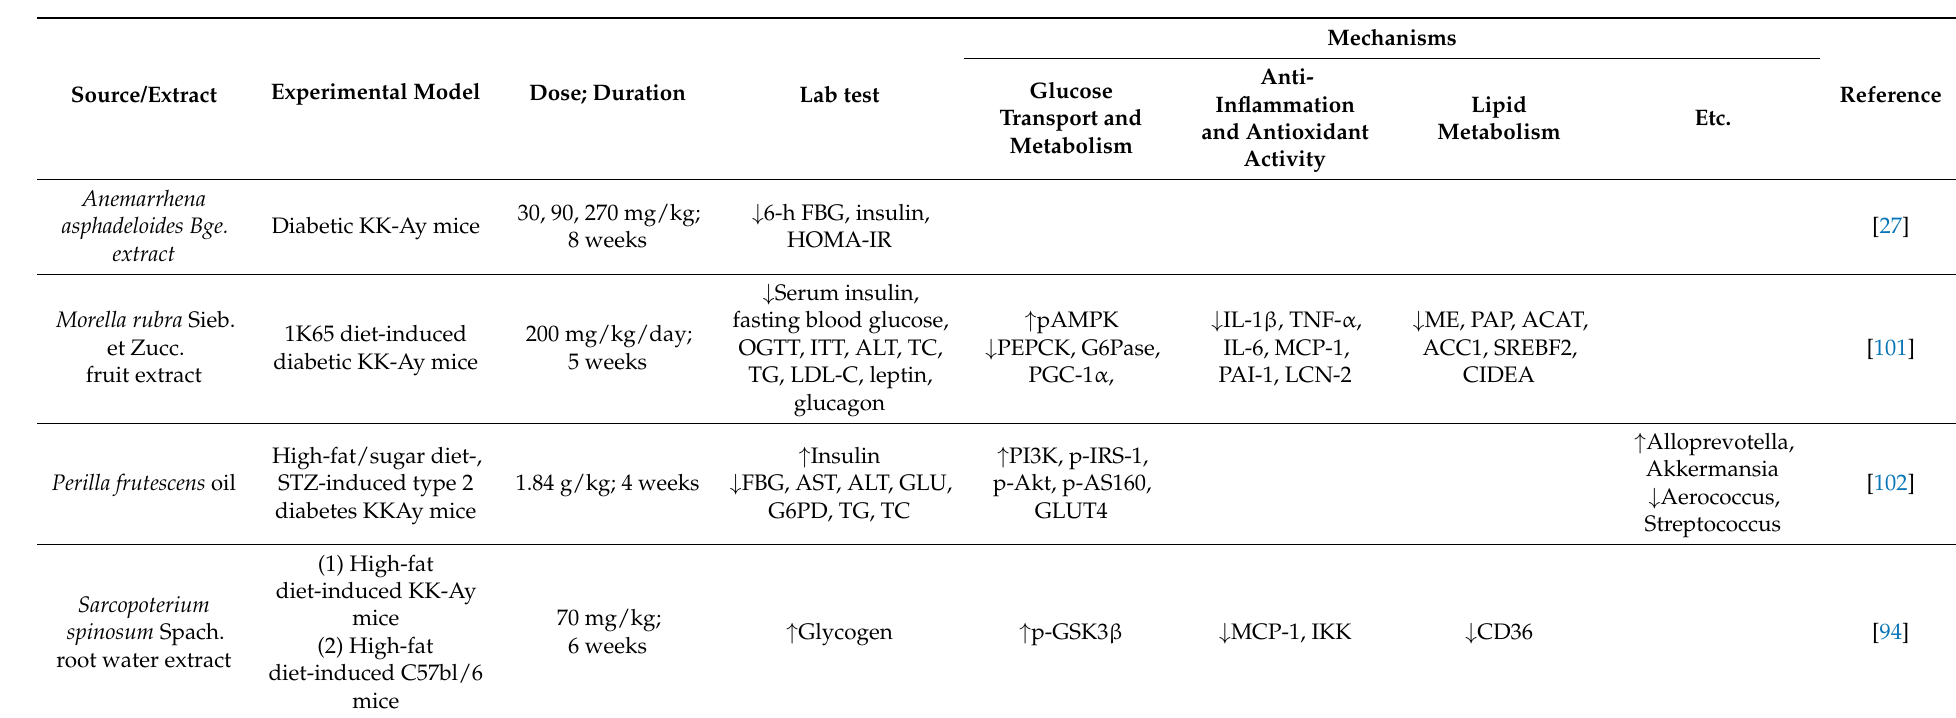
Table 5. In vivo studies—KK-Ay